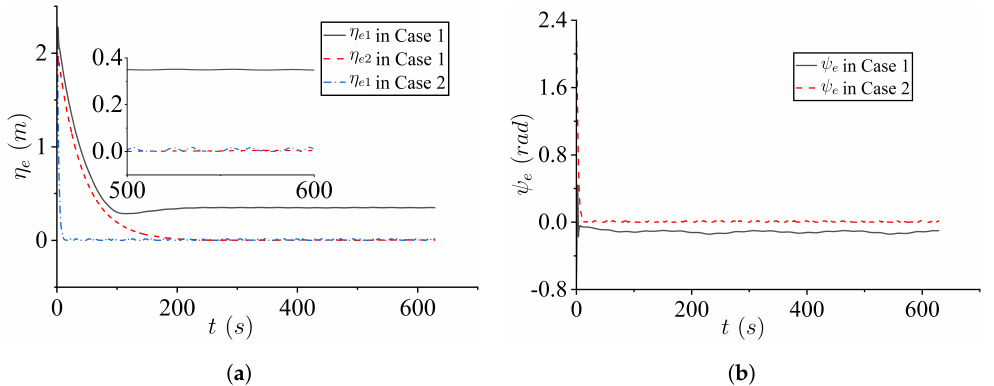
Figure 4. The tracking errors in Case 1 and Case 2: ( a ) position error, ( b ) heading angle